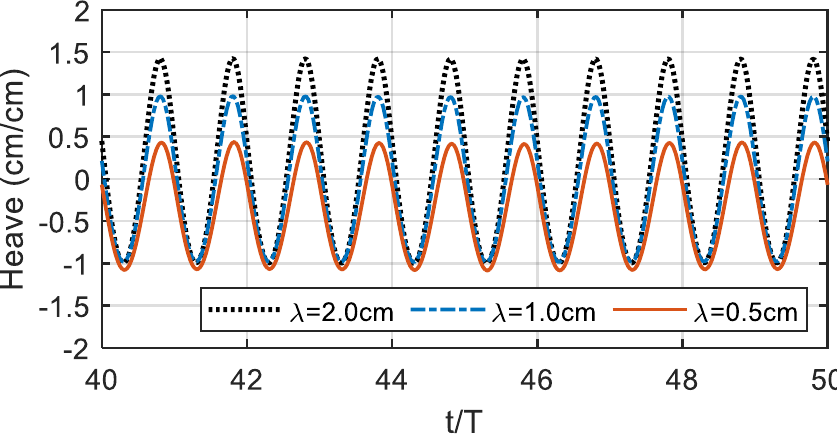
Figure 8. Variations in the heave motion for the platform with various fishnet mesh sizes ( H = 4 cm, T = 0.91 s, and σ 2 h / g = 3.9).